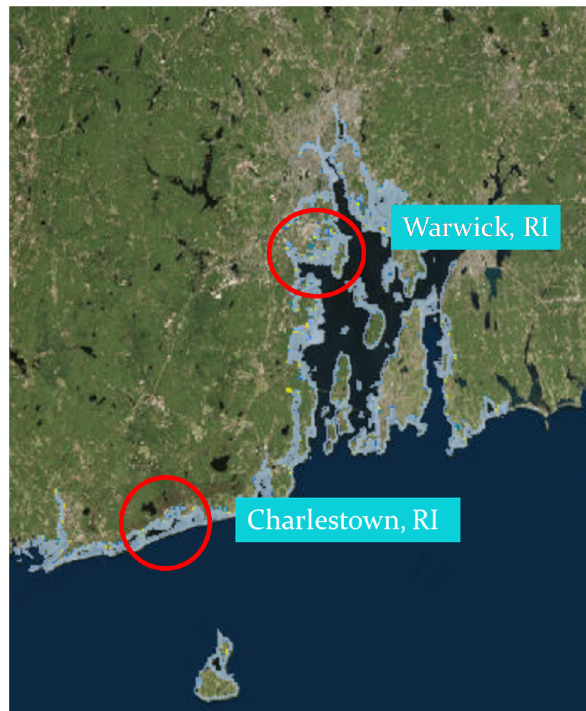
Figure A1. RI study area with locations of Charlestown and Warwick, RI highlighted. Background of map is 100 year flooding with no SLR.